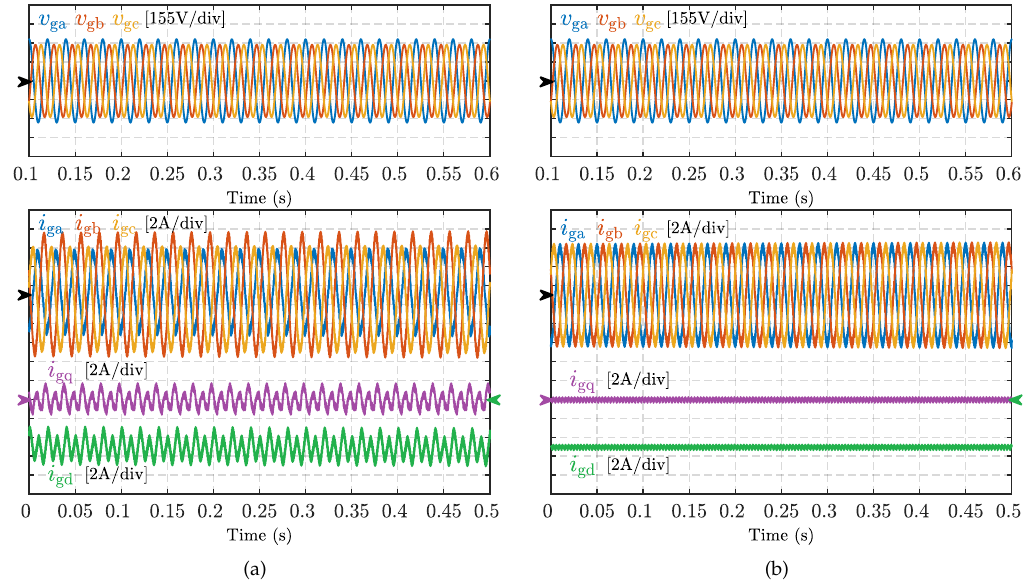
Figure 13. Simulated results under unbalanced network condition: ( a ) Traditional controllers without additional compensation schemes; ( b ) The proposed dual-loop controller.